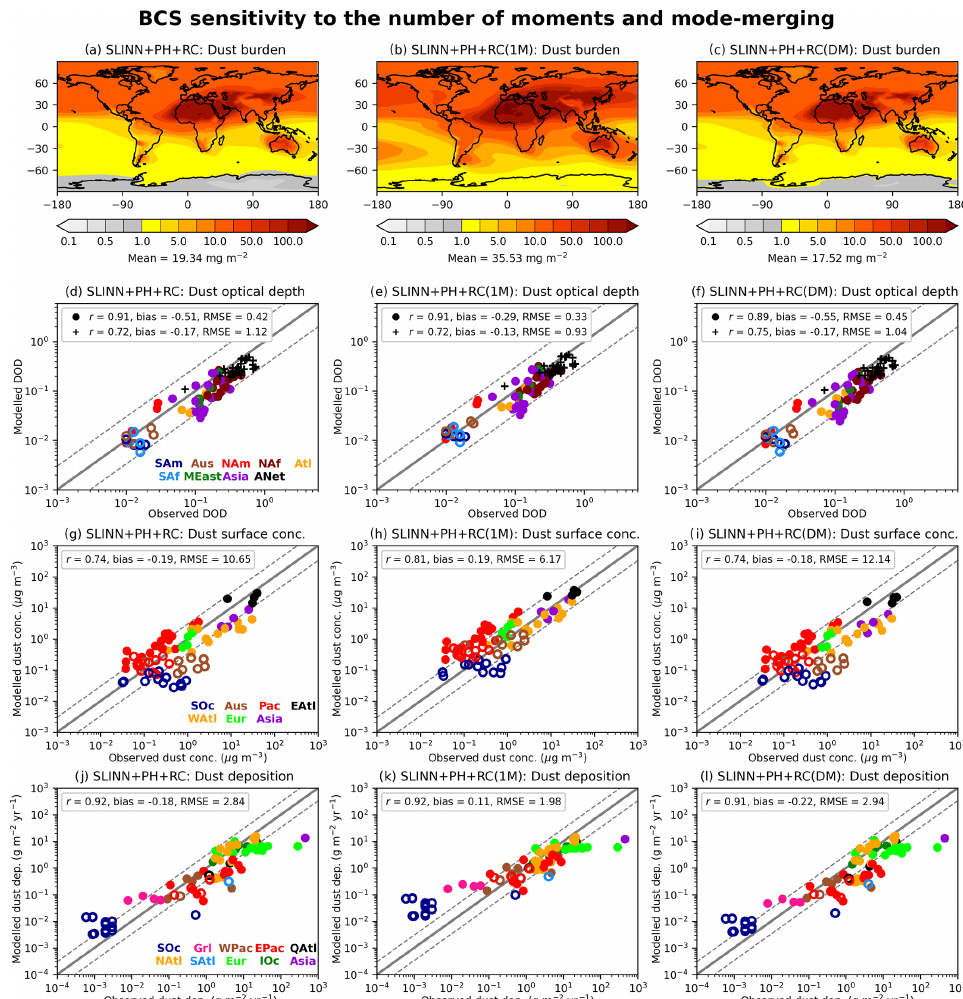
Figure 9. The same as Figs. 7–8 but for SLINN + PH + RC, SLINN + PH + RC(1M), and SLINN + PH + RC(DM). Used to answer KQ3, single- vs. double-moment BCS schemes, and KQ4, impact of representing downward mode